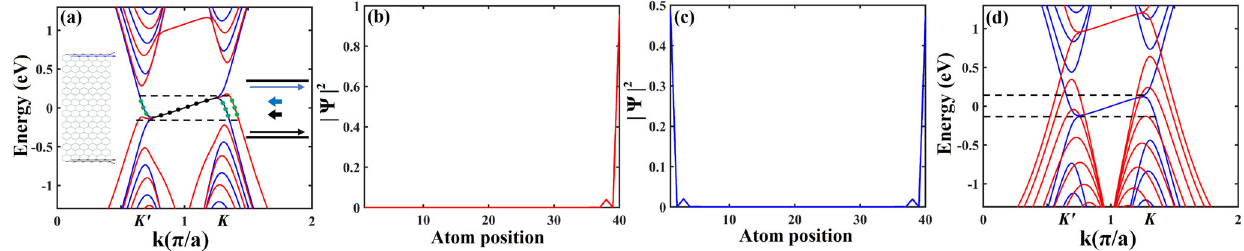
Fig. 4 The band structure, local bond current distribution and probability distribution for antichiral edge states. a The band structure of one case of Type-1 with U 1 = 0.2 t and M 1 = 0.2 t along the boundaries. Inset: local current distribution ( E = 0.03 eV) and schematic diagram of corresponding edge states. b , c Corresponding probability distribution of edge states near the Fermi energy. d The band structure of zHNRs with the modi fi ed Haldane model under the external fi elds U a = 0.2 t and M a = 0.2 t . The black bands (arrows) denote the spin degeneracy case, and the red (blue) bands or arrows denote the spin-up (down) case. Other fi xed parameters are the same as in Fig.